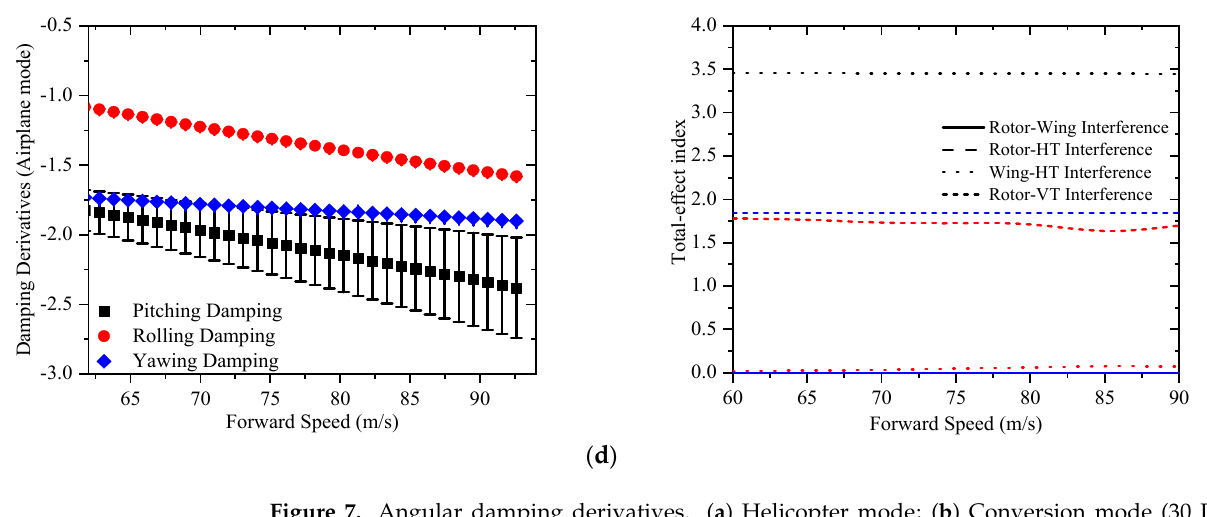
Figure 7. Angular damping derivatives. ( a ) Helicopter mode; ( b ) Conversion mode (30 Deg); ( c ) Conversion mode (60 Deg); ( d ) Airplane mode.